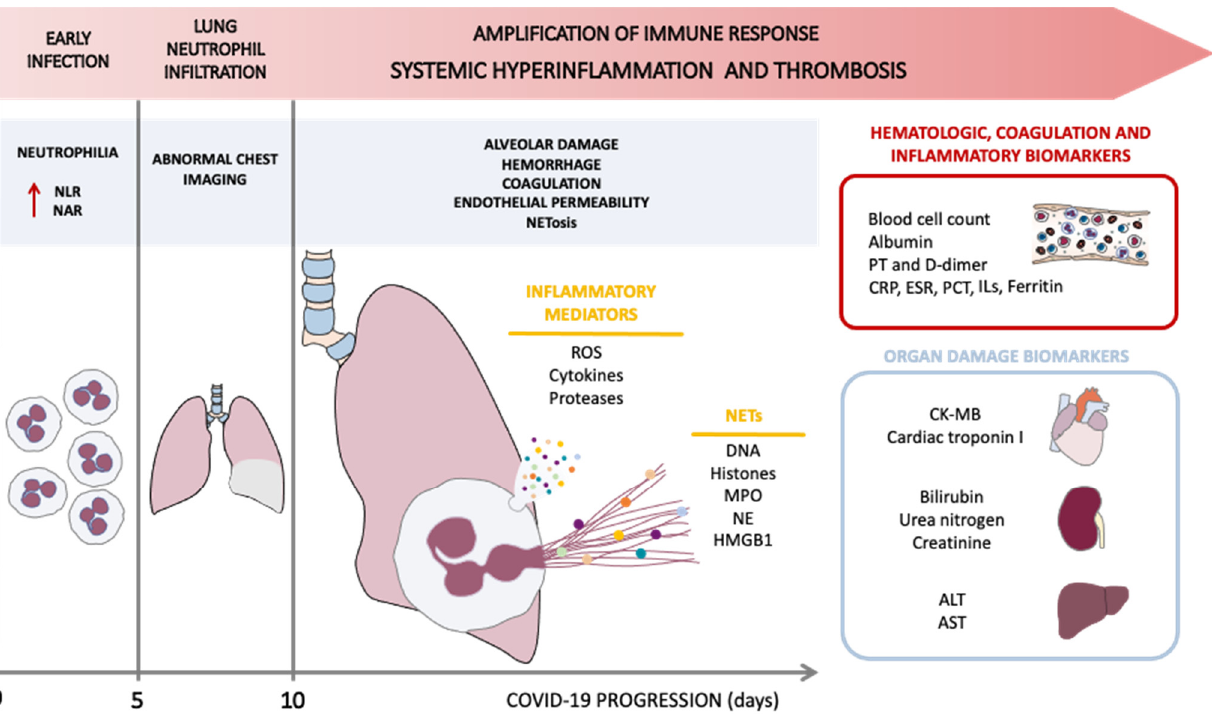
Figure 1. NETs involvement in the amplification of the systemic inflammatory and thrombotic response. SARS-CoV-2 infection presents different phases, accompanied by clinical biomarkers. Early infection, at 0–5 days, is characterized by neutrophilia and increases in the neutrophil-to-lymphocyte ratio (NRL) and neutrophil-to-albumin ratio (NAR). In approximately five days, patients present abnormal chest imaging (presenting ground-glass opacities of the lungs) with lung neutrophil infiltration. From approximately day 10, there is an amplification of immune-response-triggered systemic inflammation and thrombosis; this phase involves the release of inflammatory mediators, such as reactive oxygen species (ROS), cytokines, proteases, and neutrophil extracellular traps (NETs). This induces alveolar damage, hemorrhage, coagulation, endothelial permeability, and NETosis, increasing the severity of COVID-19. The following NETs components are released during NETosis: DNA, histones, myeloperoxidase (MPO), neutrophil elastase (NE), and high-mobility group box